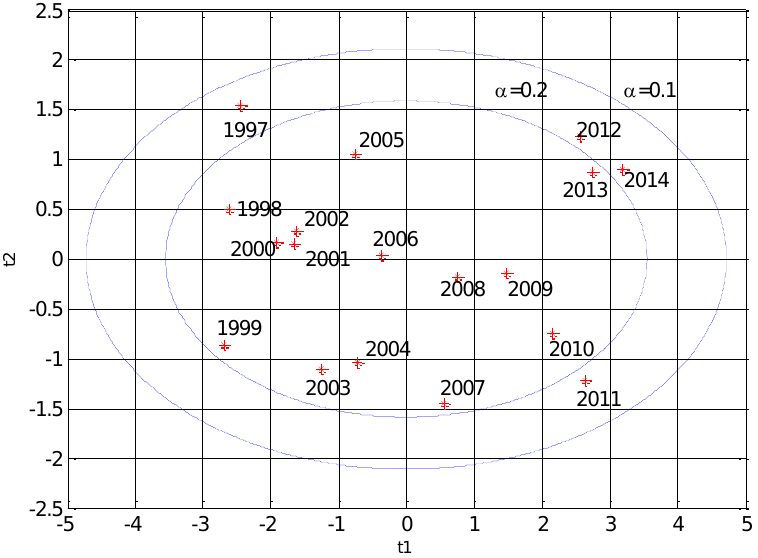
Figure 1. Distribution of outliers with different confidence levels ( α